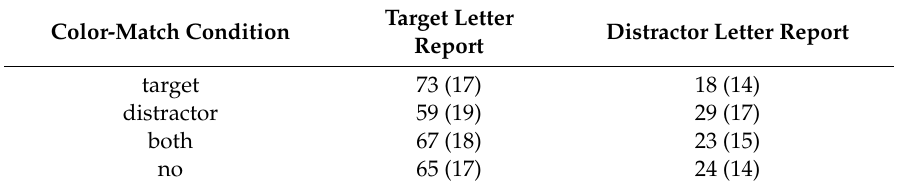
Table 1. Means and standard deviations (in brackets) in percent of reported target and distractor letters for the four color-match conditions of Experiment 1.